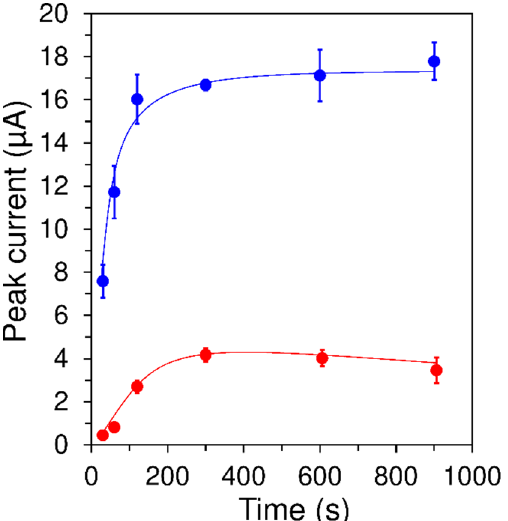
Figure 1. Dependence of anodic peak current phylloquinone (VK1) (red) and of (+)-α-tocopherol (α-TOH) (blue line) on adsorption time. square-wave adsorptive stripping voltammetry (SWAdSV) of 50-µmol L −1 α-TOH and 50-µmol L −1 VK1 adsorbed from its 50% aqueous–acetonitrile mixture onto a glassy carbon electrode (GCE) at stirring rate 400 rpm for different time durations. Voltammetric detection was carried out in 0.01-mol L −1 HNO 3 containing 0.1-mol L −1 KCl (pH 2.08) at E dep = −0.1 V, t dep = 60 s, t eq = 5 s, E step = 5 mV, E ampl = 25 mV and f = 20 Hz.